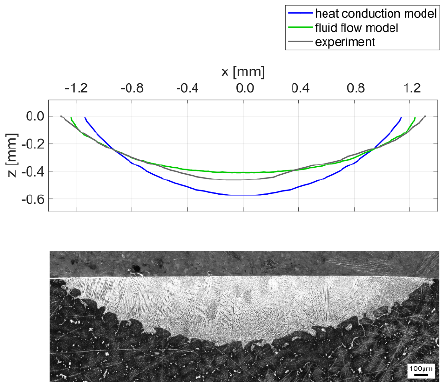
Figure 13. Comparison of the melt pool geometries obtained by two different numerical approaches and the experimental result for P = 1000 W, v = 400 mm/min, T = 20 °C.